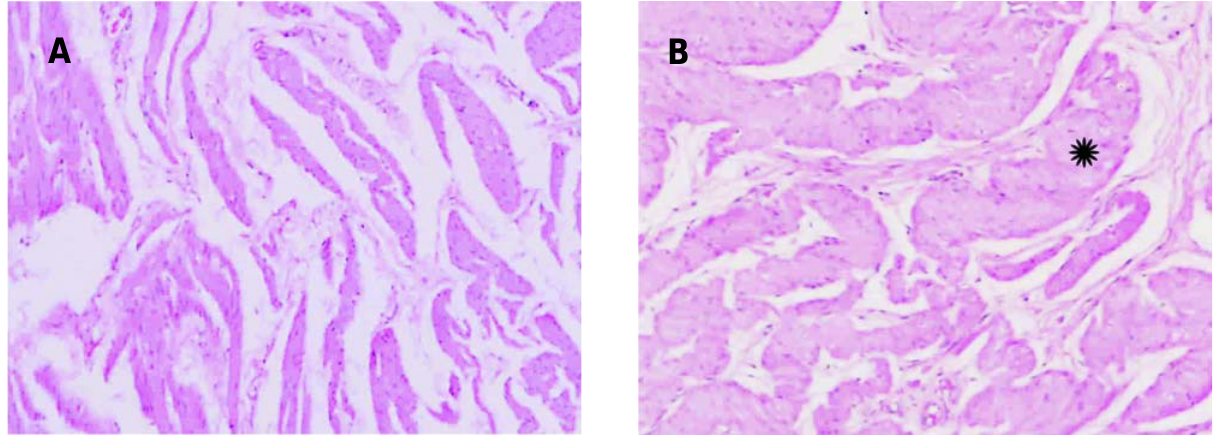
Figure 2 – Histological section of rabbit bladder. A) Absence of muscular hypertrophy in group G1 (HE, X40). B) Intense hypertro- phy in group G2 (asterisk), HE